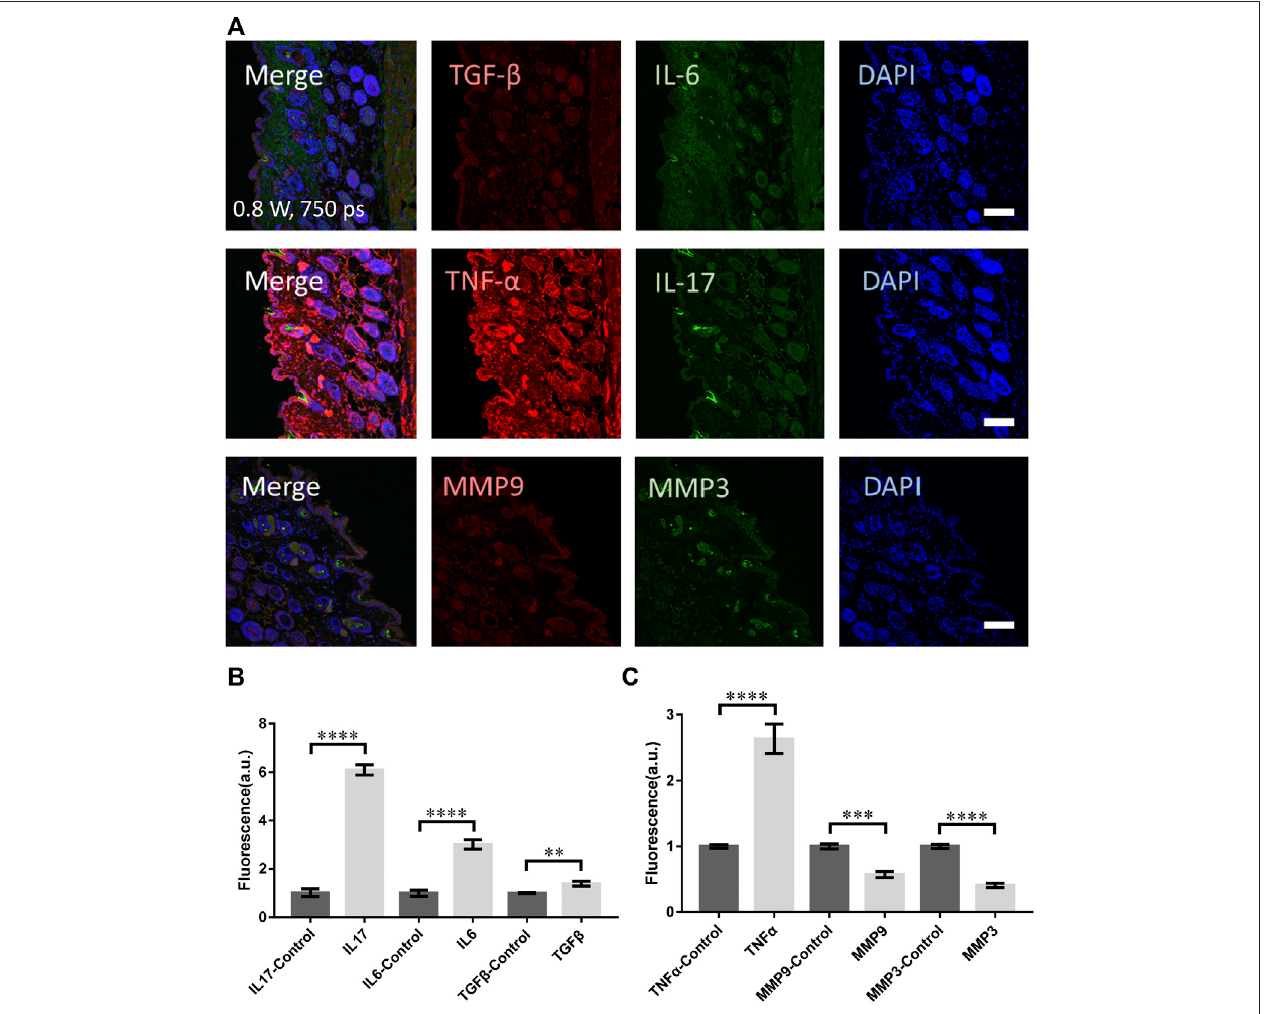
FIGURE5 | The molecularresponsesofskin tothe clinical picosecond laser at 755 nm,irradiation at 0.8 W for 6 s. (A) The immuno fl uorescence images and (B,C) thestatisticalanalysisofthesampleswithandwithoutlasertreatmentrespectively.n (cid:1) 6samplesfromthreeindependenttrails.Bar:100 μ m.*p < 0.05.** p < 0.01.*** p < 0.001. **** p < 0.0001, by students ’